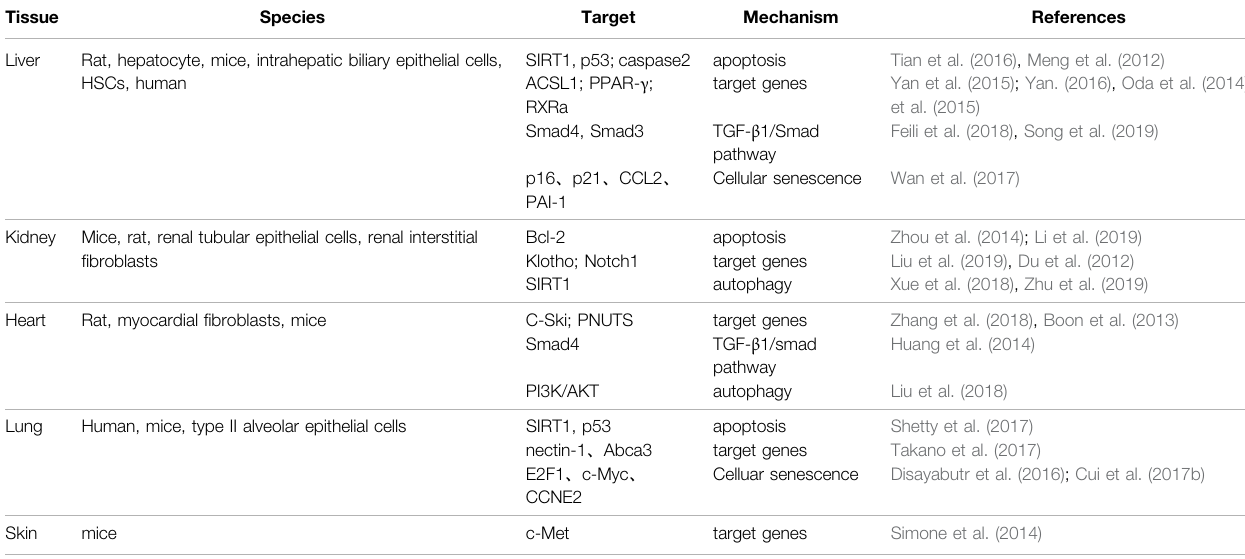
TABLE 1 | MiR-34a acts on various organ fi brosis.